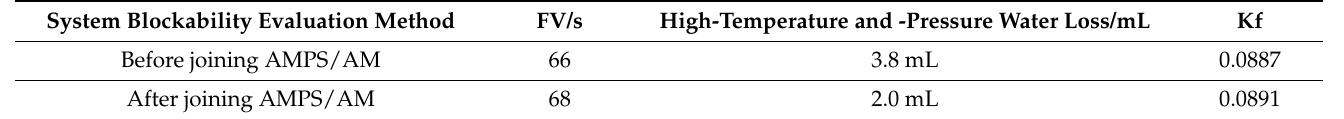
Table 5. Field evaluation of plugging performance of water-based drilling fluid